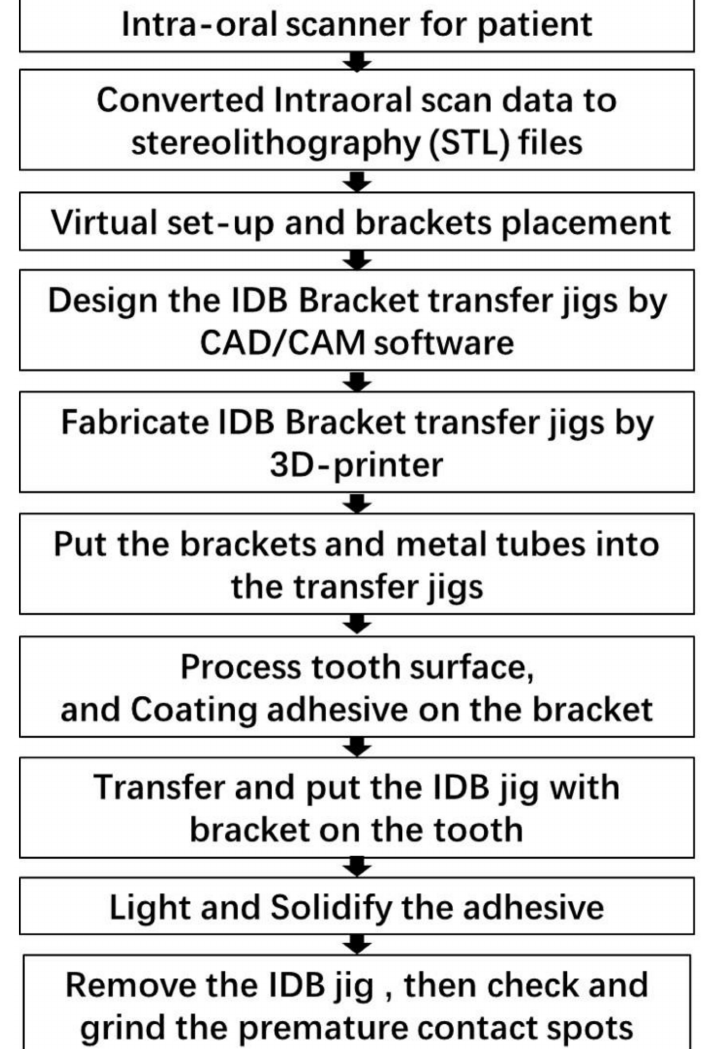
Figure 1. Clinical workflow list for indirect bonding jig system (IDBS) procedure. It takes 10 days to receive jigs after intraoral scanning and ordering. CAD/CAM, computer-aided design, and manufacturing; 3D,